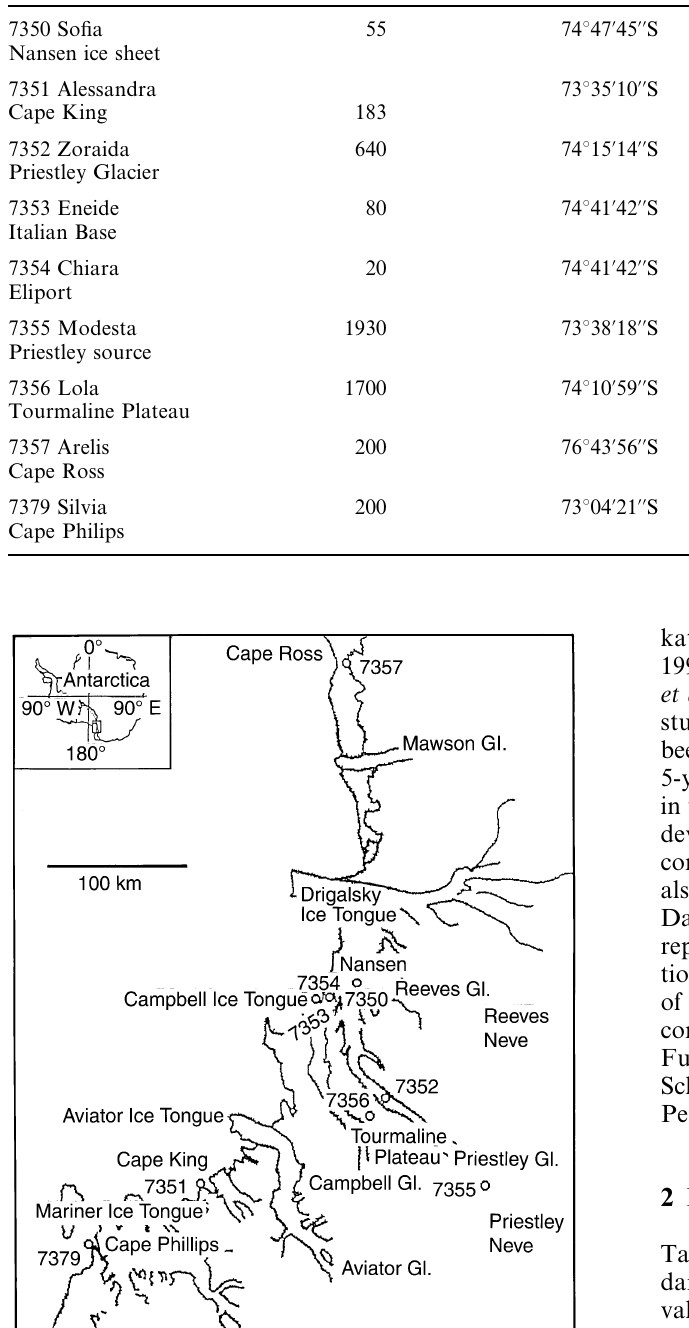
( ° C), minimum temperature ( ° C), maximum temperature ( ° C), dew point temperature ( ° C), atmospheric pressure (hPa), barometric trend (hPa), average solar radiation (W/m (cid:50) ), maximum solar radiation (W/m (cid:50) ).